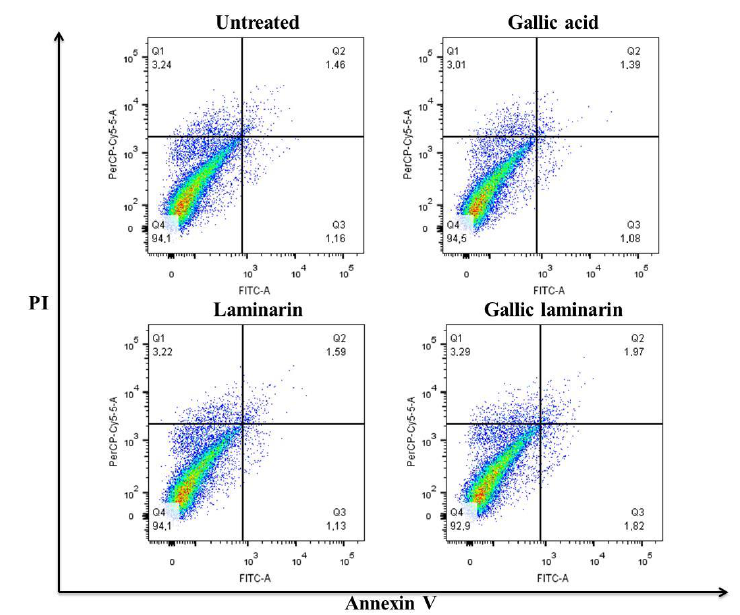
Figure 10. Flow cytometry analysis of MDCK cells stained with annexin ( x -axis) and propidium iodide(PI) ( y -axis). Antioxidants 2020 , 9 , x FOR PEER REVIEW